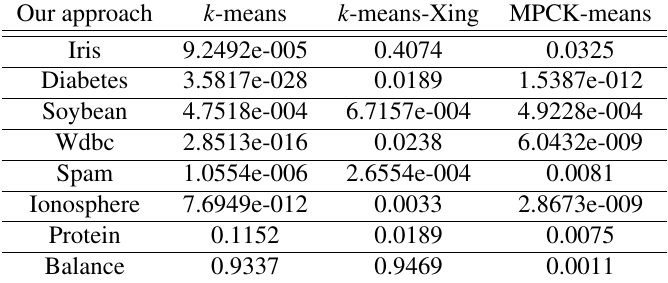
Table 4. t -test under NMI